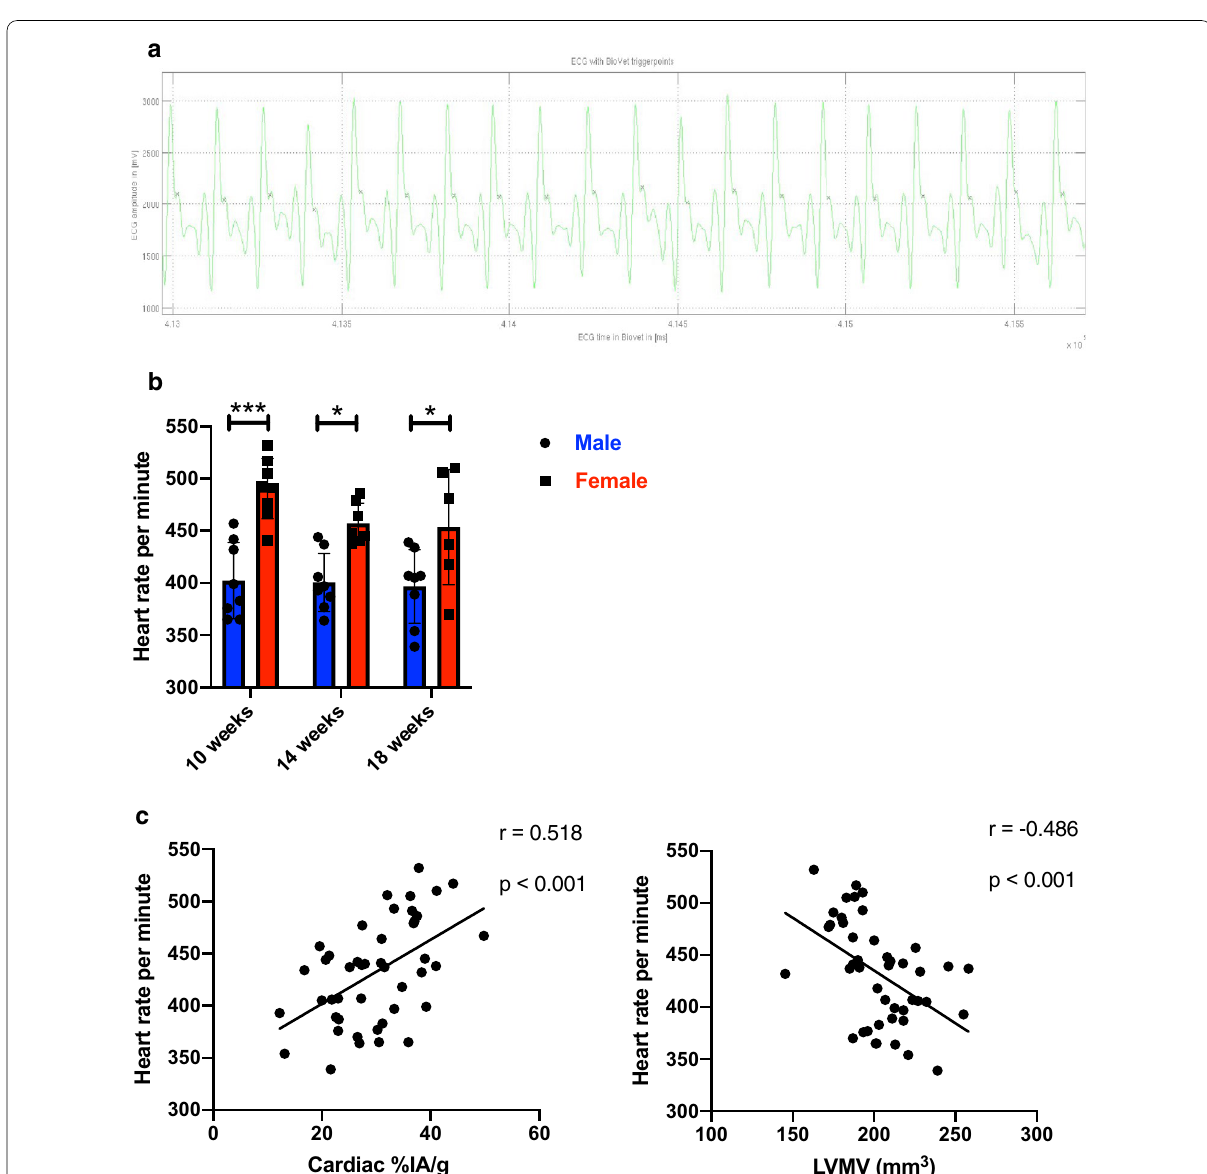
Fig. 3 ECG analysis in both genders. a depicts the ECG tracking during the PET scan. Small black crosses in the QRS complex demonstrate the time of the trigger event. b ECG assessment of the heart rate in both genders during the PET scans. c Correlation of heart rate with cardiac LVMV and %IA/g, respectively. All groups n 7–8 at different time points and cumulative group size in correlations n = < 0.05, ** p < 0.01, *** p <